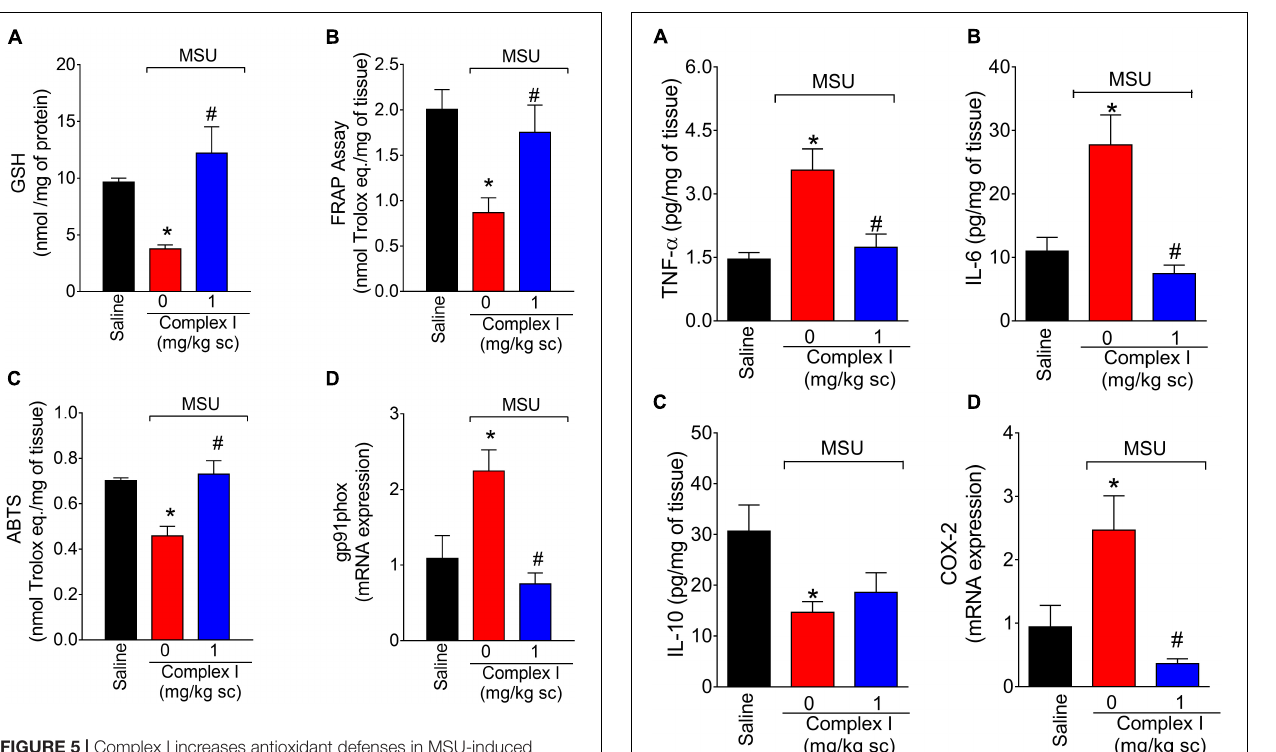
FIGURE 5 | Complex I increases antioxidant defenses in MSU-induced arthritis. Mice were treated with complex I (1 mg/kg/saline, s.c.) or vehicle 30 min prior to intra-articular stimulation with MSU (100 µ g/10 µ l) and after 15 h knee joints samples were collected to the GSH (A) , FRAP (B) and ABTS (C) assays and gp91phox (D) mRNA expression evaluation. Results are expressed as mean ± SEM ( n = 6 per group per experiment, representative of two experiments). ∗ p < 0.05 compared to saline group and # p < 0.05 compared to MSU + vehicle. One-way ANOVA followed by Tukey’s test.